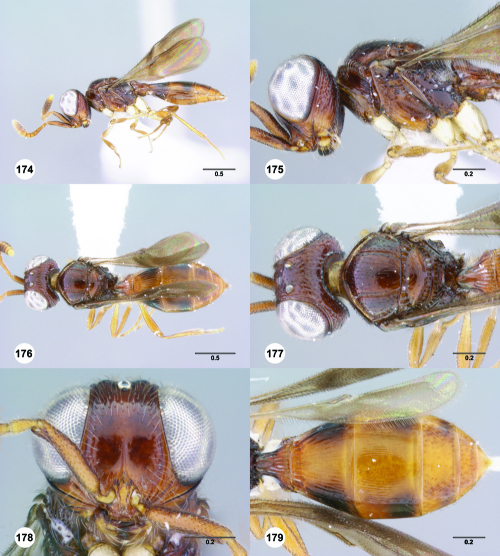
96Trichoteleia nify sp. n. 174 Lateral habitus, female holotype (CASENT 2135909) 175 Head and mesosoma, lateral view, female holotype (CASENT 2135909) 176 Dorsal habitus, female holotype (CASENT 2135909) 177 Head and mesosoma, dorsal view, female holotype (CASENT 2135909) 178 Head, anterior view, female (CASENT 2135910) 179 Metasoma, dorsal view, female (CASENT 2135910). Scale bars in millimeters.